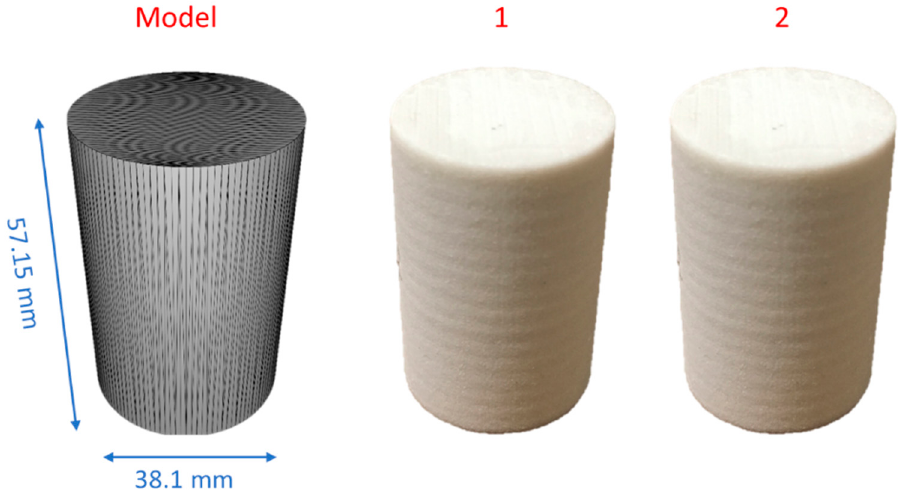
Figure 1. Surface model representing 3D printed cylindrical samples 1 and 2